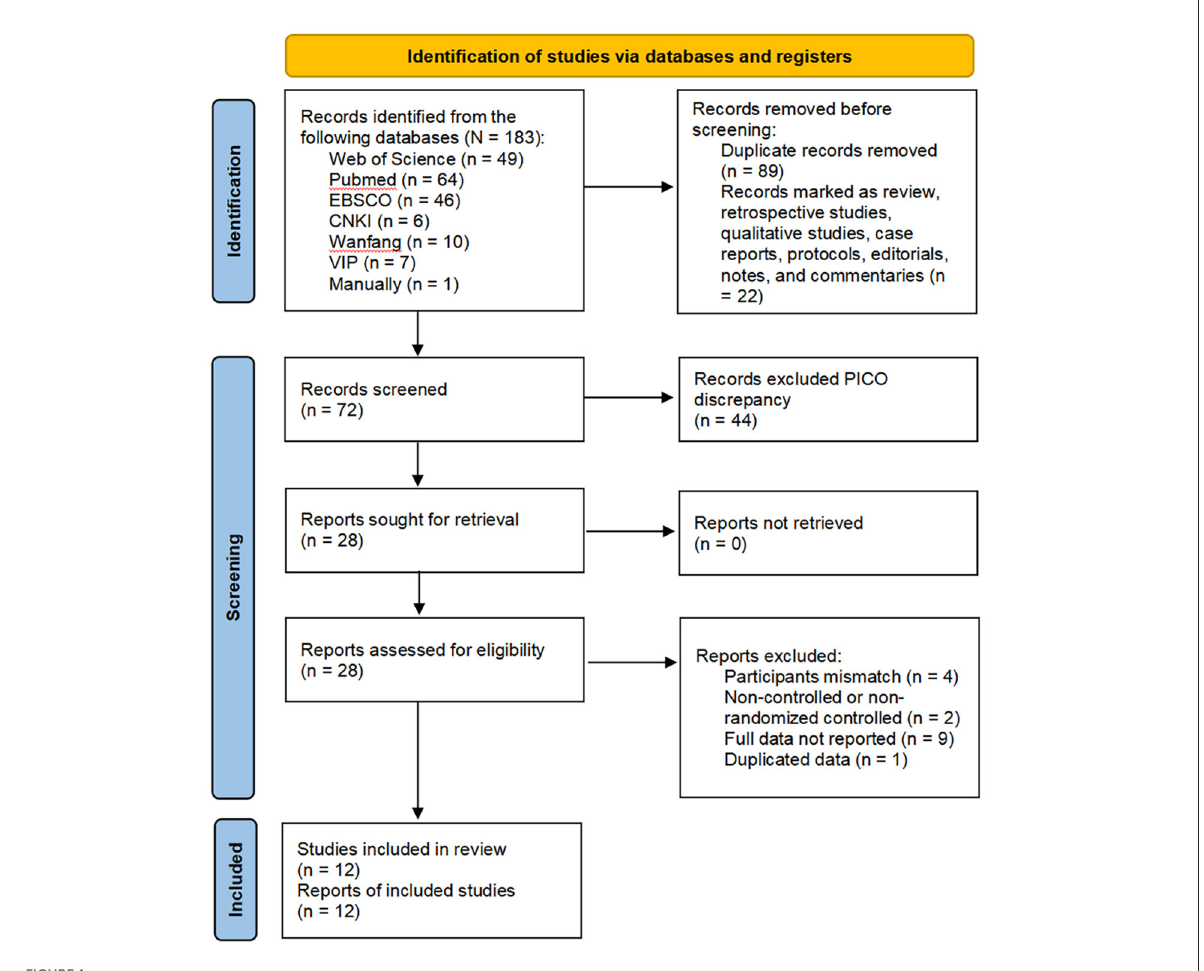
FIGURE1 Literature selection flow diagram.